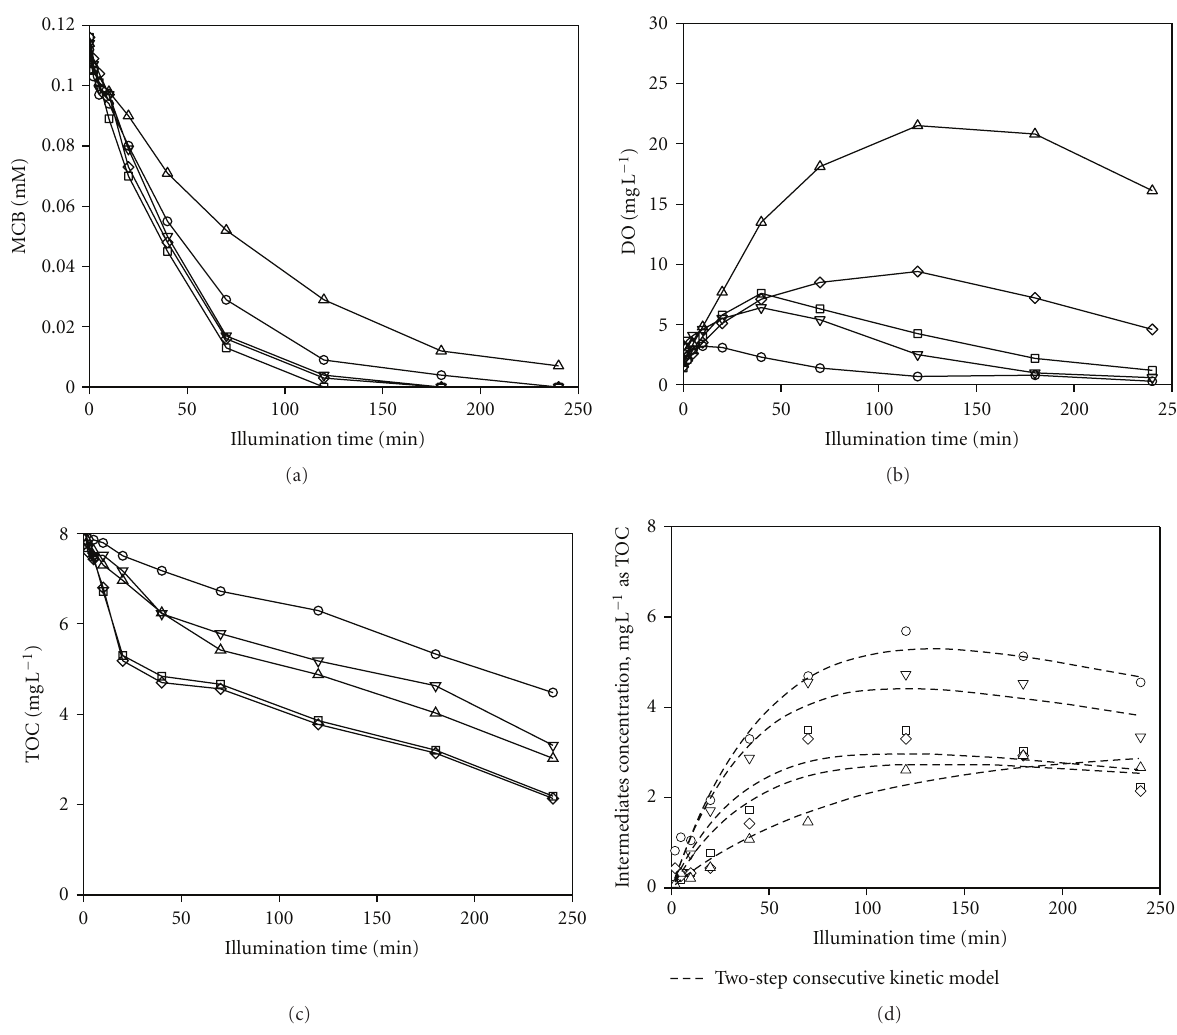
Figure 3: Concentration profiles for (a) MCB, (b) DO, (c) TOC, and (d) intermediates during photocatalytic degradation of MCB at various H 2 O 2 dosages: ( (cid:4) ) 5.6 mgL − 1 , ( (cid:6) ) 11.2 mgL − 1 , ( (cid:7) ) 22.5 mg L − 1 , ( ♦ ) 45.0 mg L − 1 , and ( (cid:5) ) 78.0 mgL − 1